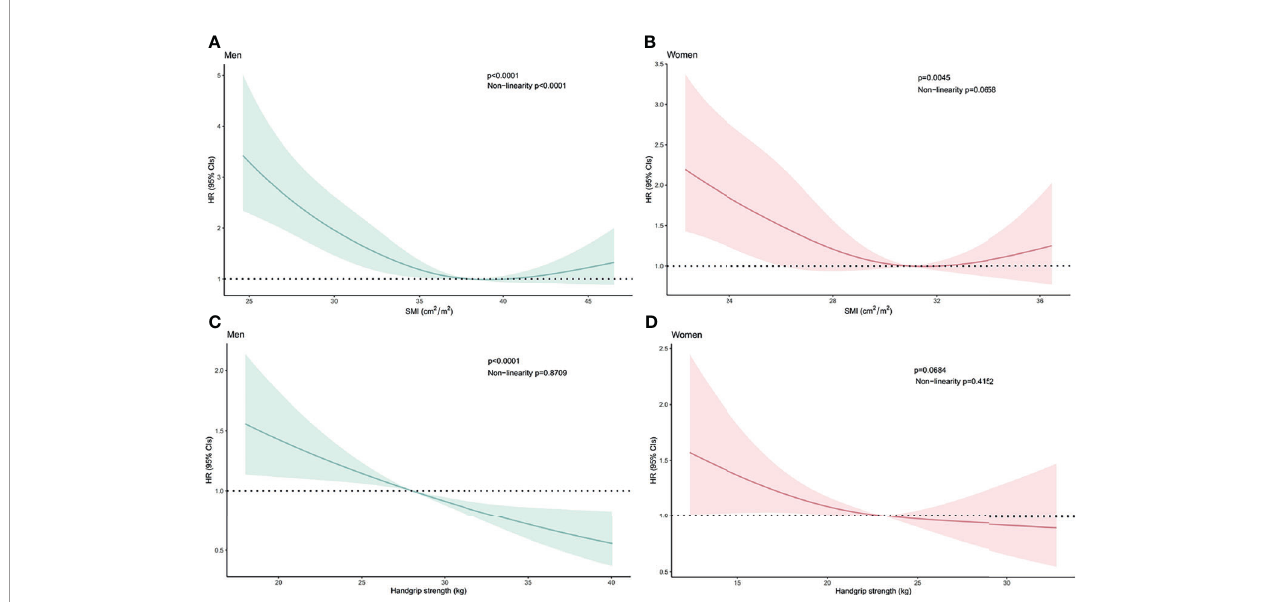
FIGURE 1 | Hazard Ratios of Overall Survival Related to (A) the Skeletal Mass Index at the 12th Thoracic Vertebra Level (T12 SMI) in Men, (B) the T12 SMI in Women, (C) Handgrip Strength in Men, and (D) Handgrip Strength in Women. Hazard ratios of the T12 SMI and handgrip strength were estimated as continuous data using a restricted cubic spline function with three knots. Bold lines represent the curves for the estimated hazard ratios related to the T12 SMI or handgrip strength in men and women. Shadowed areas indicate the corresponding 95% con fi dence intervals. CI, con fi dence interval; HR, hazard ratio.